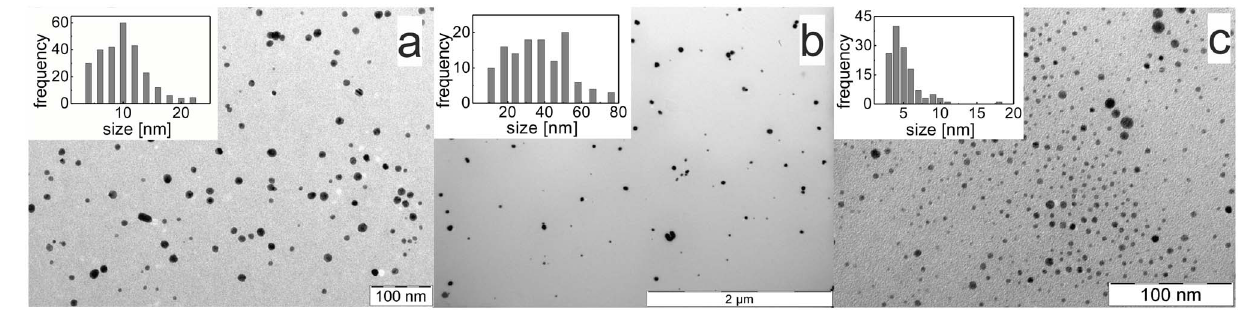
Figure 1. TEM images and corresponding particle size distribution histograms of AgNPs reduced by maltose (a), ascorbic acid (b), and sodium borohydride (c) in the presence of gelatin. The concentration of gelatin was 0.025% (w/w).